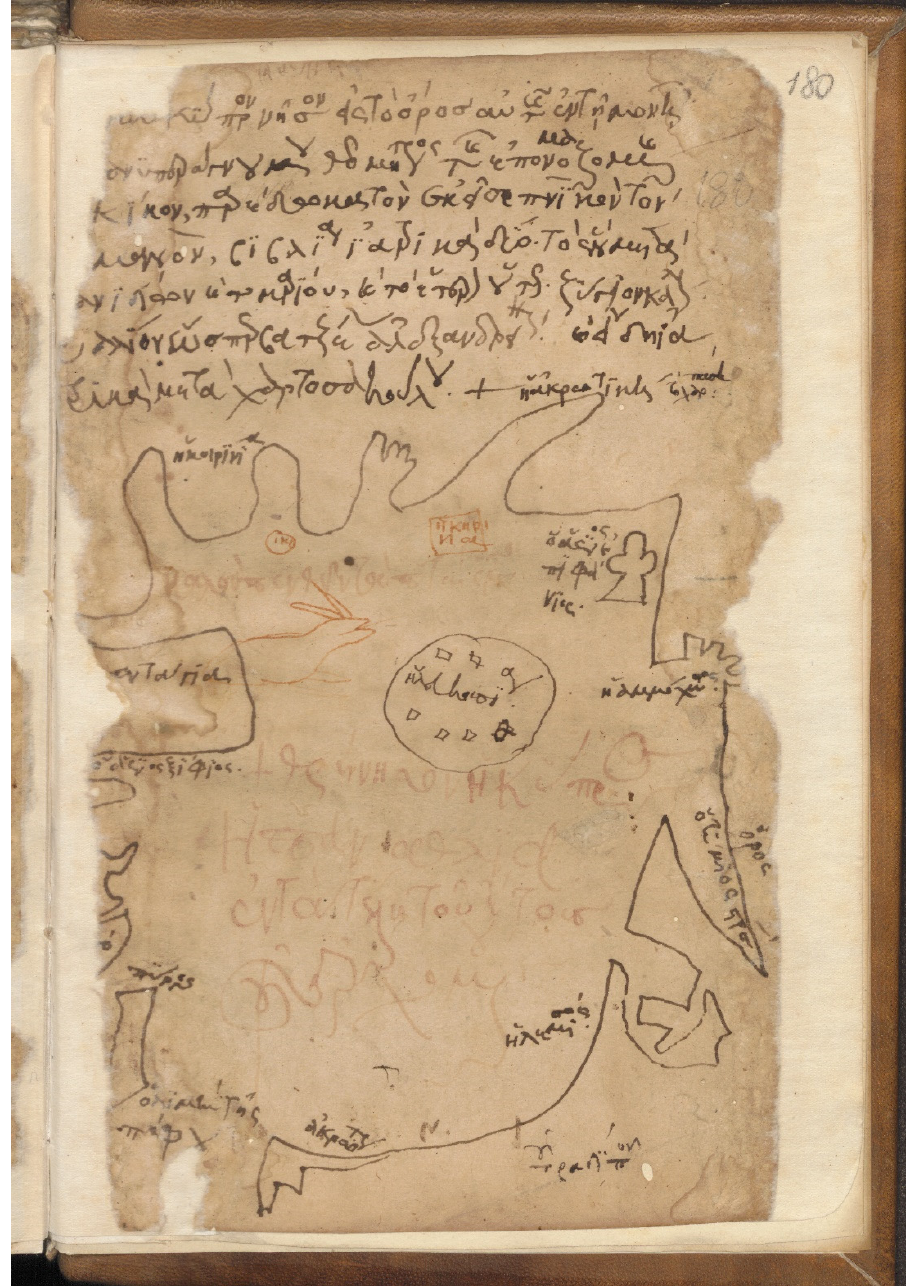
Figure 1. The Ambrosiana map of Cyprus. Milan, Ambrosiana MS A95 sup., f. 180r. First half of the fourteenth century (Reproduced with permission from the Veneranda Biblioteca Ambrosiana, Mi-